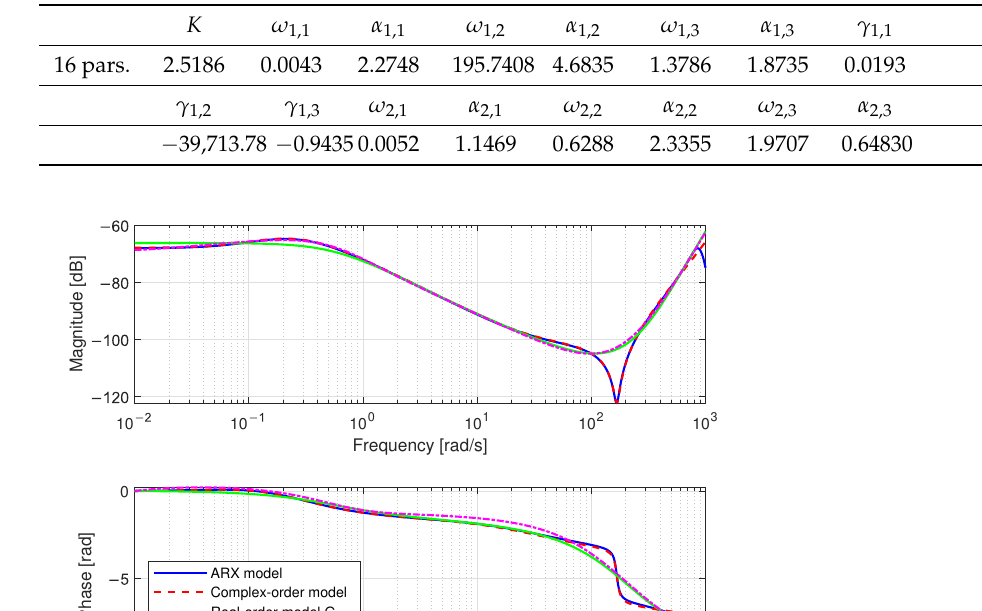
Table 4. Parameters of the fitted 16-parameter real-order model.